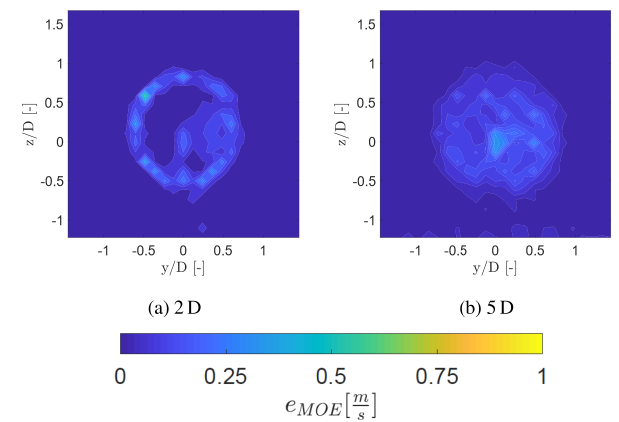
Figure 18. Margin of error ( e MOE ) of the streamwise velocity at 2 and 5 D for the inflow without a grid.